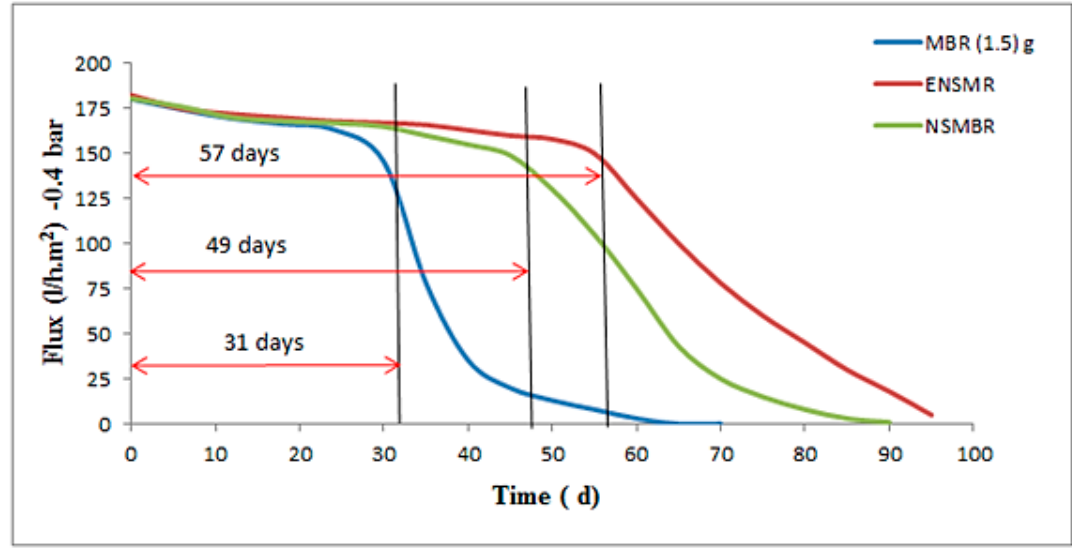
Figure 6. Step II, The effect of the electro field on the lifetime of the PPUS/ZnO NPs membranes in the NSMBR and ENSMBR system.